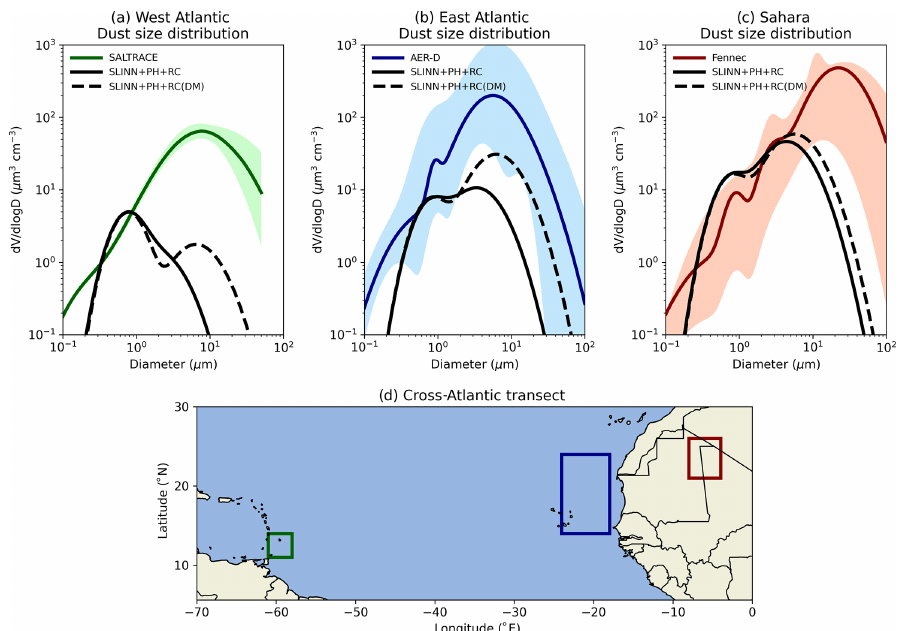
Figure 10. Dust volume size distributions in a cross-Atlantic transect in the SLINN + PH + RC and SLINN + PH + RC(DM) simulations for (a) June conditions in the region (58–61 ◦ W, 11–14 ◦ N) and 2–2.4km altitude compared to SALTRACE measurements, (b) August conditions in the region (18–24 ◦ W, 14–24 ◦ N) and 2–3km altitude compared to AER-D measurements, and (c) June conditions in the region (4–8 ◦ W, 21–26 ◦ N) and 0.1–1.2km altitude compared to Fennec 2011 measurements. Panel (d) shows the horizontal boundaries of the averaging regions in the equatorial